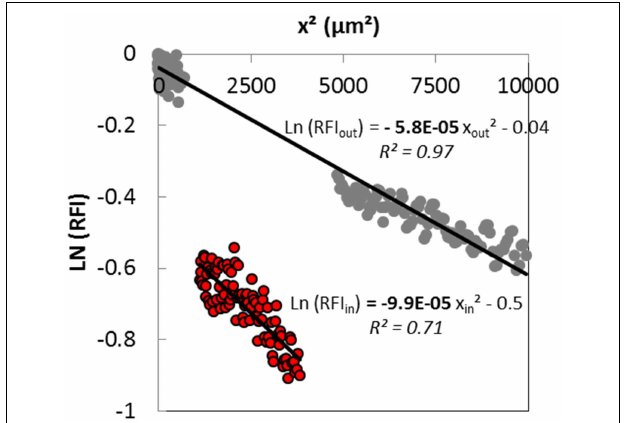
FIGURE 5 | Typical linearized curve obtained 30min after the deposit of the fluorescent solution containing a 70kDa dextran at the surface of the model cheese inoculated with Lactococcus lactis LD61. Lines correspond to the linear fit of experimental data both outside (gray circles) and inside the colony (red circles).